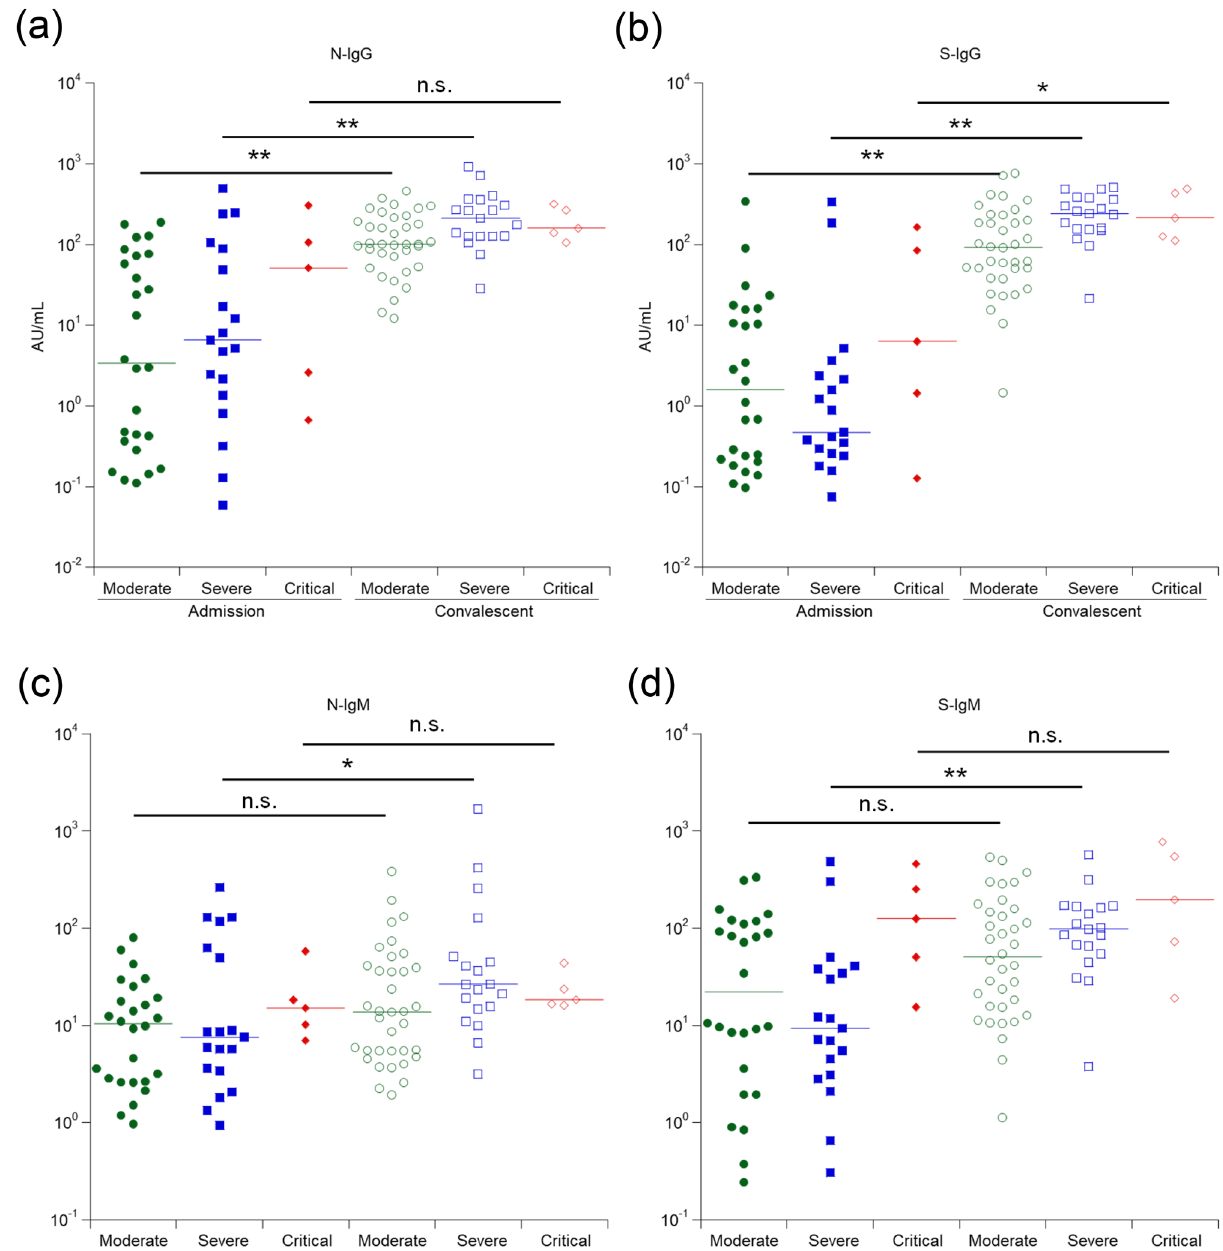
Figure 4. Relationship between severity status and antibody levels. Comparison of antibody titers on admission and convalescent for N-IgG ( a ), S-IgG ( b ), N-IgM ( c ), and S-IgM ( d ). *P > 0.05 , **P >